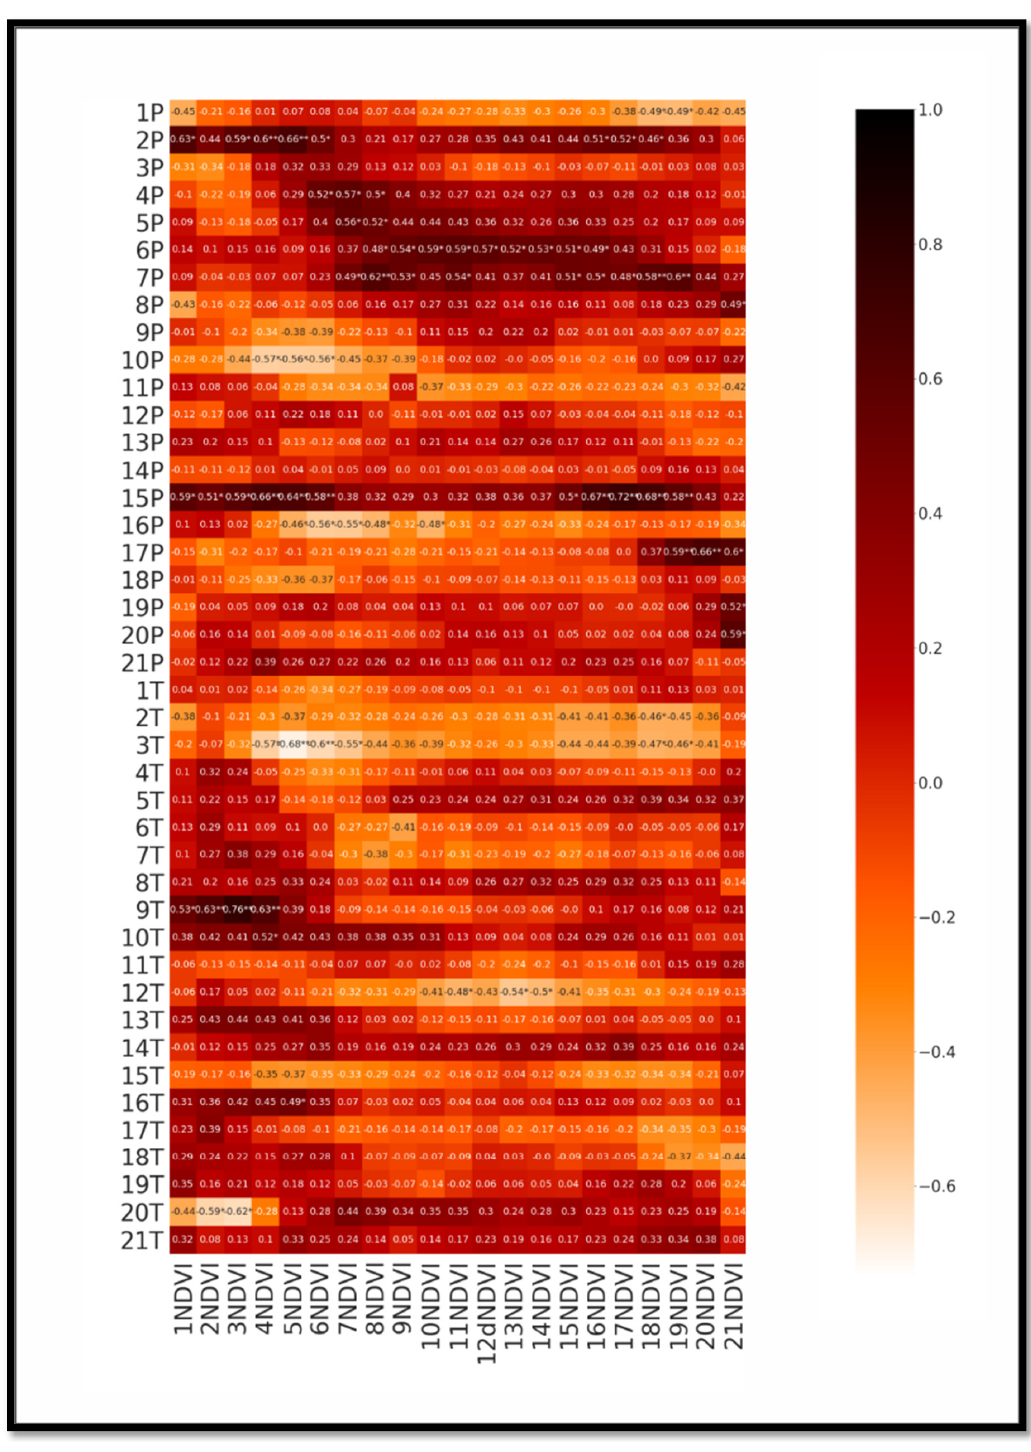
Figure 2. Correlation between 10-day values of temperature, precipitation and BRDF NDVI for Meghri, with the levels of significance: *— p < 0.05, ** p < 0.01.